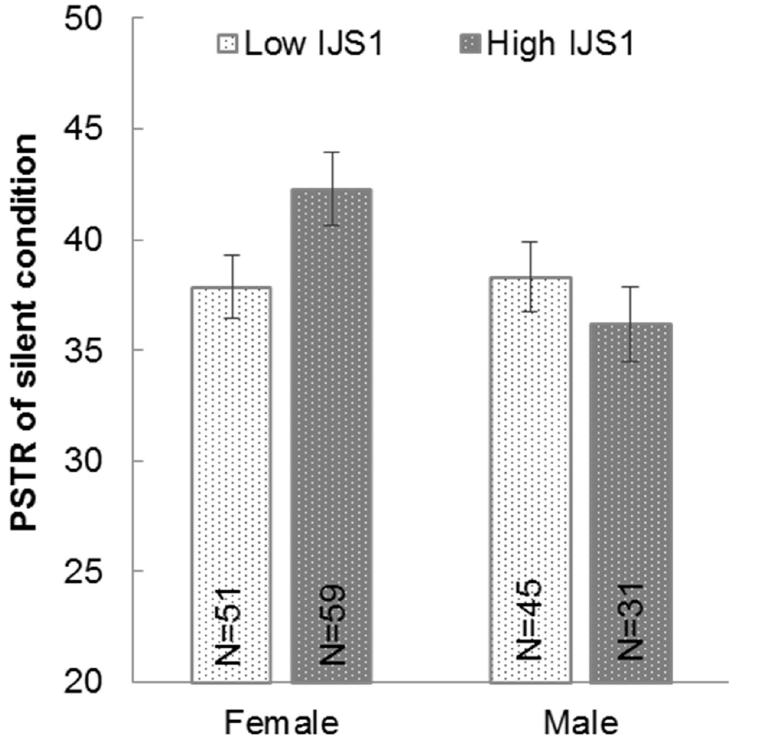
Fig 7. PSTRs of low and high IJS1 groups of each gender when walking in